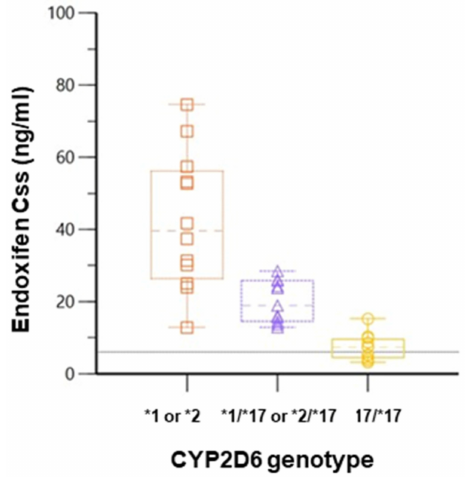
Figure 4. Simulated steady state concentrations of ENDO in CYP2D6 genotype arms, with horizontal line highlighting ENDO therapeutic threshold as reported by Madlensky [14]. Boxes interquartile range (IQR) including